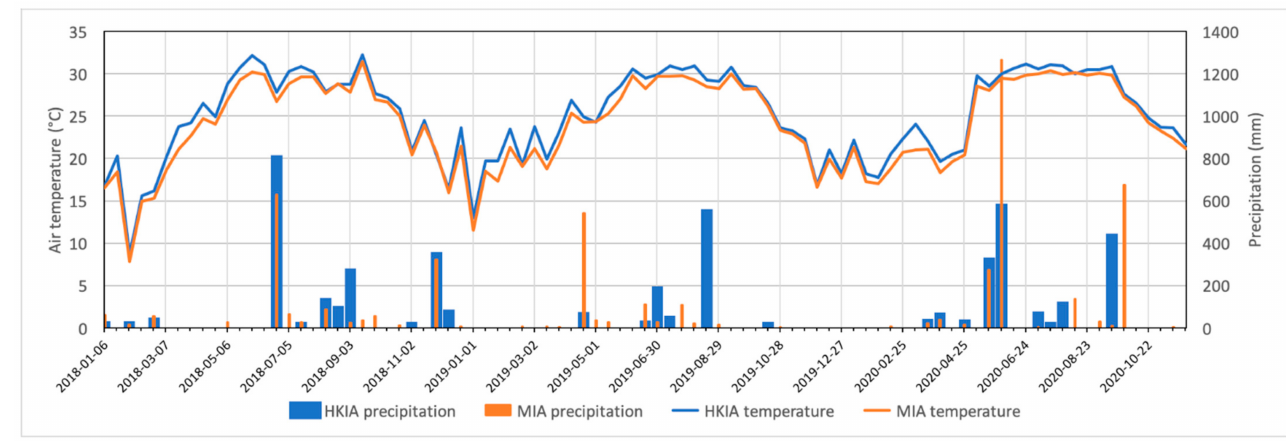
Figure 6. Air temperatures and precipitations on the acquisition dates of two meteorologic stations in the HKIA and the